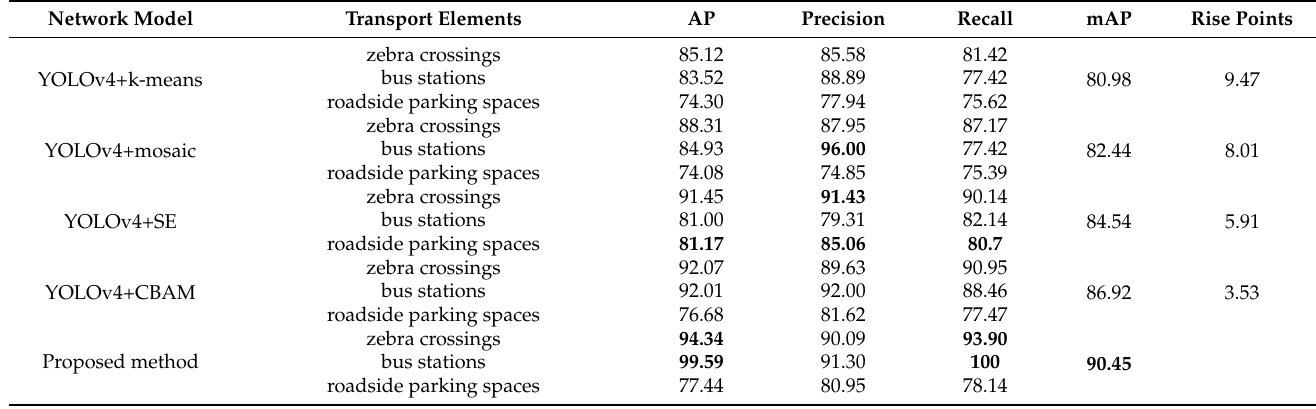
Table 3. Results of ablation